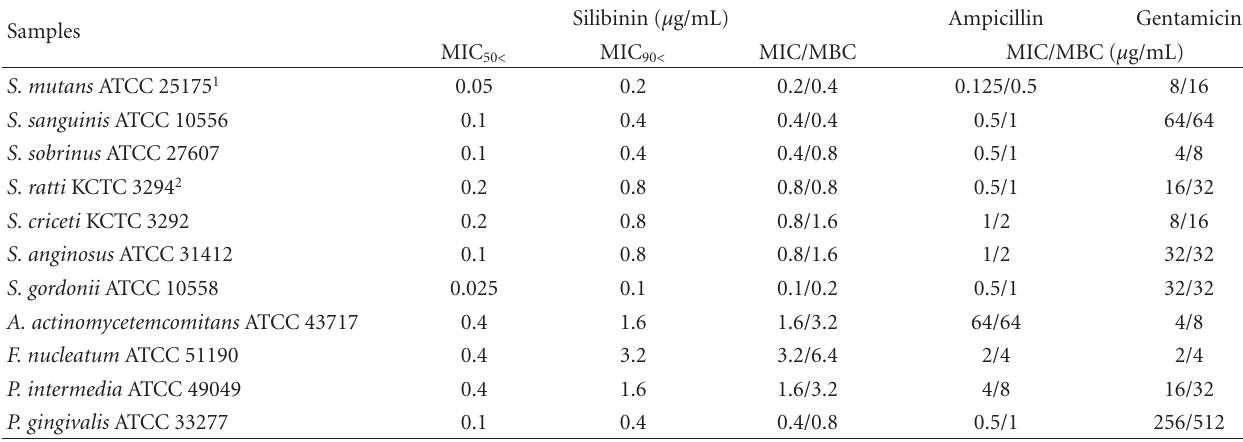
Table 1: Antibacterial activity of silibinin and antibiotics in oral bacteria. Samples